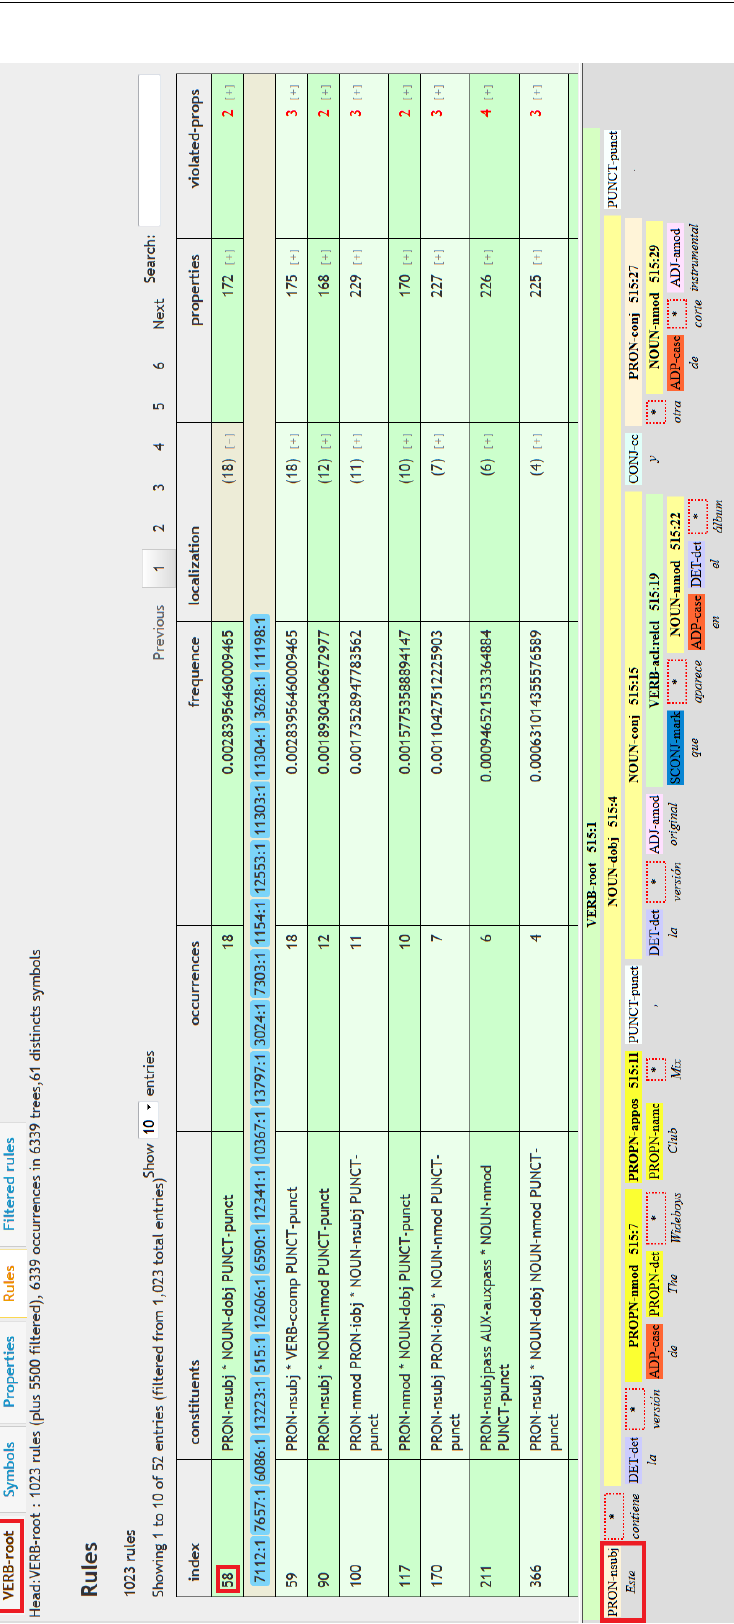
Figure 3. Example of a non-intuitive